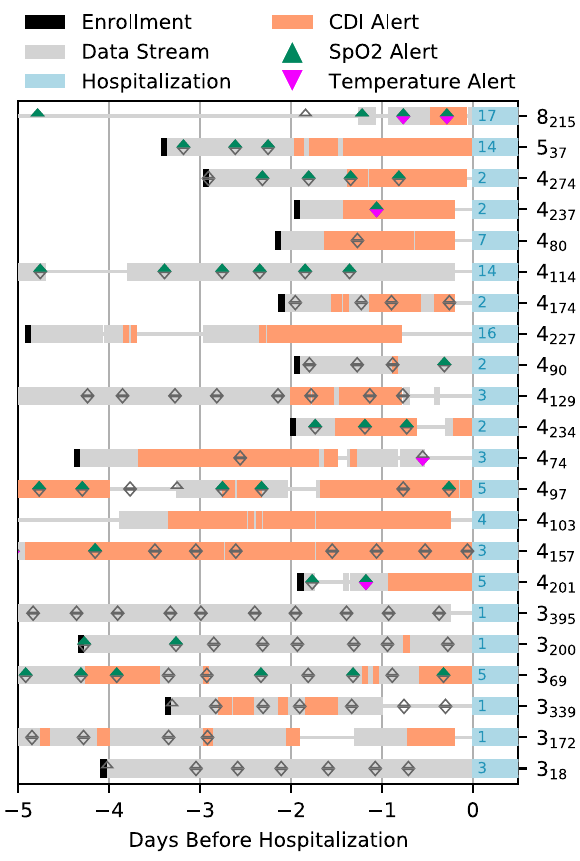
Fig. 3 Comparison of simulated standard of care alerts to CDI alerts. Along the right edge is each participant ’ s WHO score and study ID (as a subscript), along with the number of days hospitalized in blue. Each SpO 2 and temperature reading is shown as empty gray triangular indicators, each measurement above the alert indication (less than or equal to 93 O 2 , and greater than 36.11 °C) is